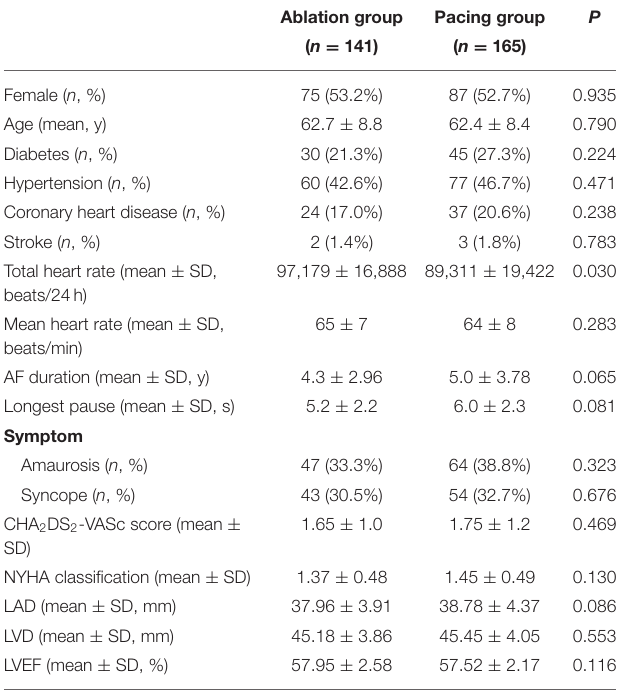
TABLE 3 | Comparison of therapeutic results between ablation group and pacing